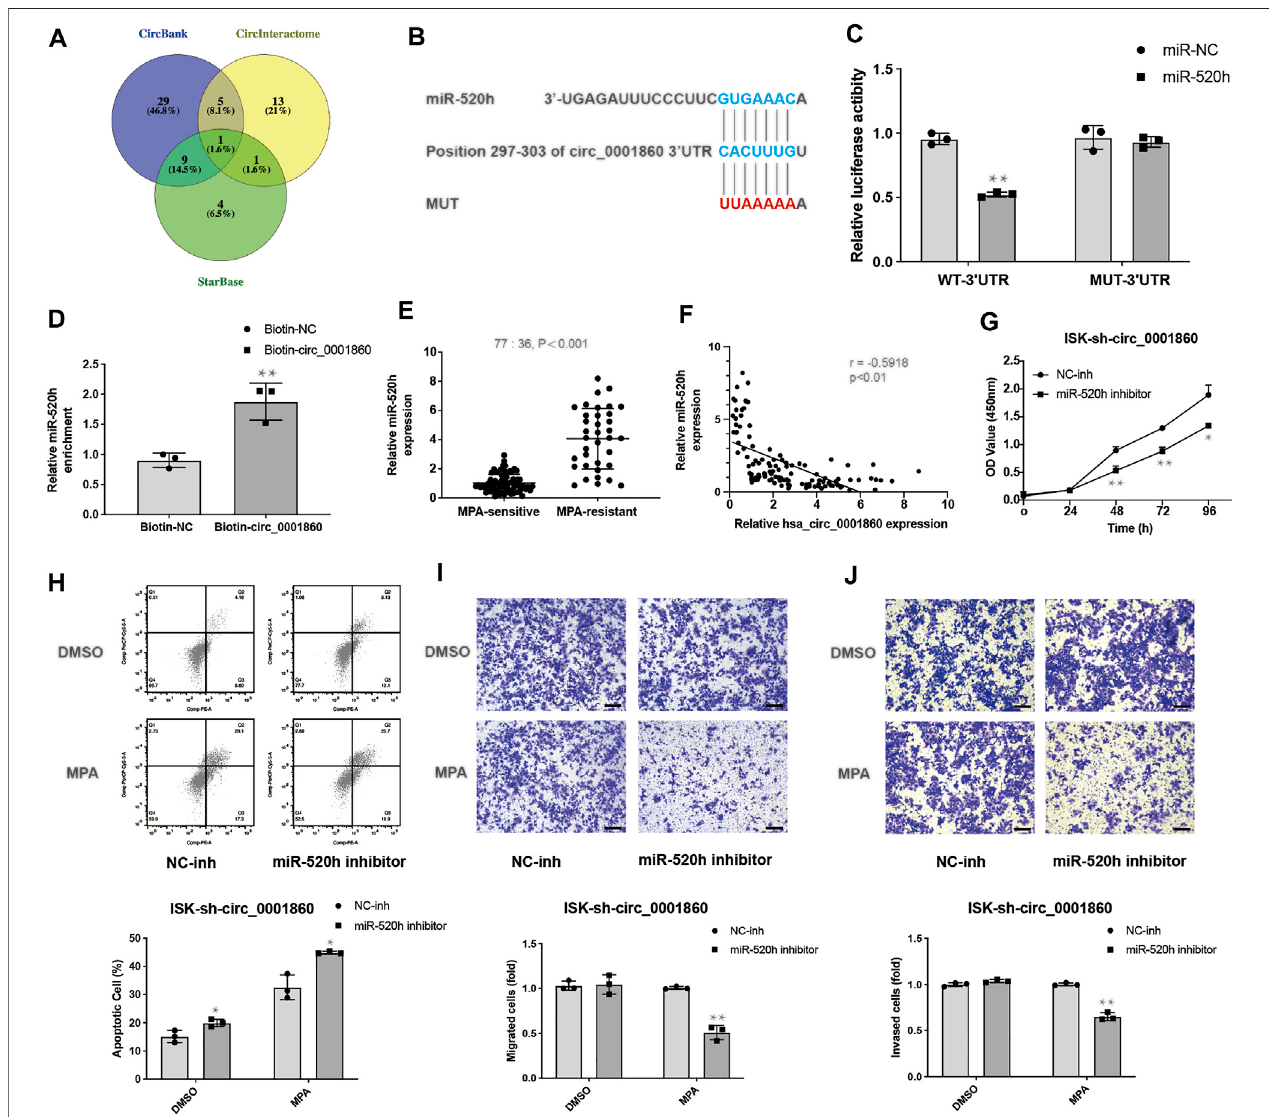
FIGURE 5 | Hsa_circ_0001860 regulates tumor progression and MPA sensitivity of EC cells via binding to miR-520 h (A) Venn diagram showing genes that are putative hsa_circ_0001860 targets computationally predicted by three algorithms (CircBank, CircInteractome, and StarBase). (B) Bioinformatics analysis predicted the presence of a binding site for hsa_circ_0001860 on miR-520 h. (C) The relative luciferase activities were analyzed in ISK cells co-transfected with miR-520 h mimics or miR-NC and luciferase reporter WT or MUT. (D) The RNA pull-down assay was executed in ISK cells to detect the enrichment of miR-520 h. (E) qRT-PCR assay showed the expression level of miR-520 h in tissue of patients from 36 MPA-resistant EC patients and 77 MPA-sensitive EC patients. (F) The expression correlation between has_circ_0001860 and miR-520 h. (G) Cell proliferation, (H) apoptosis, (I) migration, and (J) invasion of ISK cells after transfection with sh-circ_0001860 combined with miR-520 h inhibitors or NC inhibitor (magni fi cation, × 100; scale bars (cid:2) 100 μ m). * p < 0.05, ** p < 0.01, *** p < 0.001.